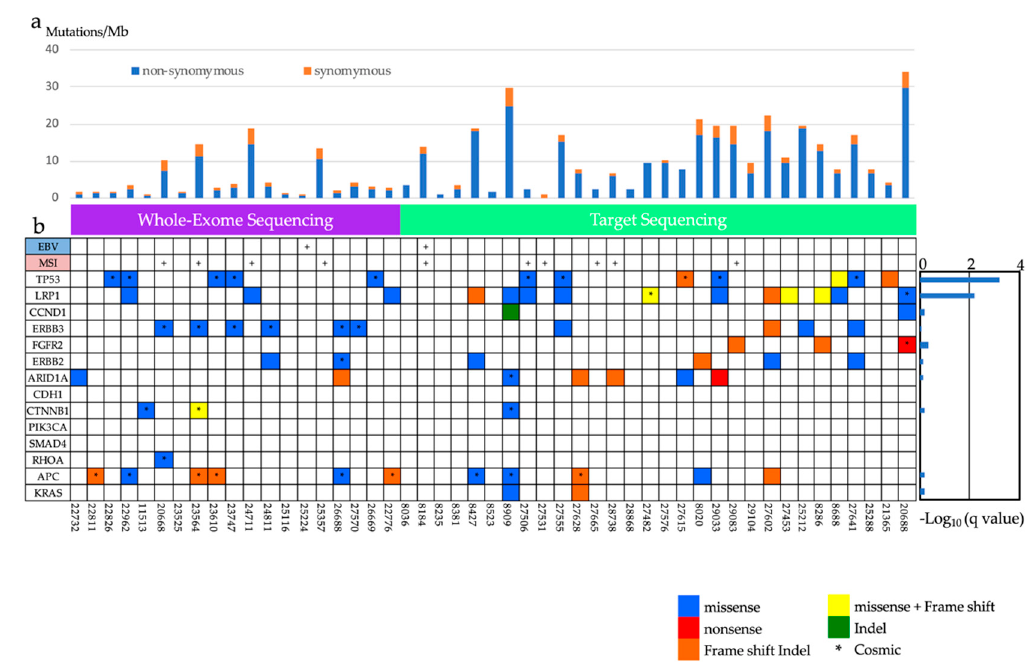
Figure 2. Summary of frequently mutated genes in 49 non-invasive GCs. ( a ) Bars represent the number of somatic mutations (somatic single-nucleotide variations (SNVs); small insertions and deletions (indels)) with synonymous and non-synonymous mutation rates distinguished by color. ( b ) Frequently mutated genes are represented by each sample. Epstein-Barr Virus (EBV)-positive cases and microsatellite instability (MSI)-positive cases are indicated at the top of the graph. Mutation color indicates the class of mutation. Twenty-eight LRP1 mutations were observed in 15 cases. EBV, Epstein-Barr virus; MSI, microsatellite instability.